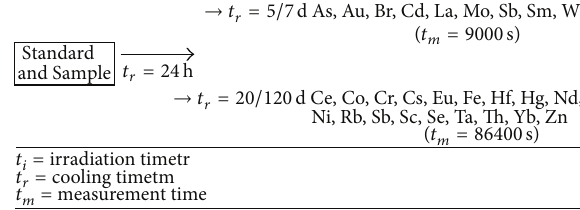
Figure 1: Scheme for INAA analysis of standards and samples.